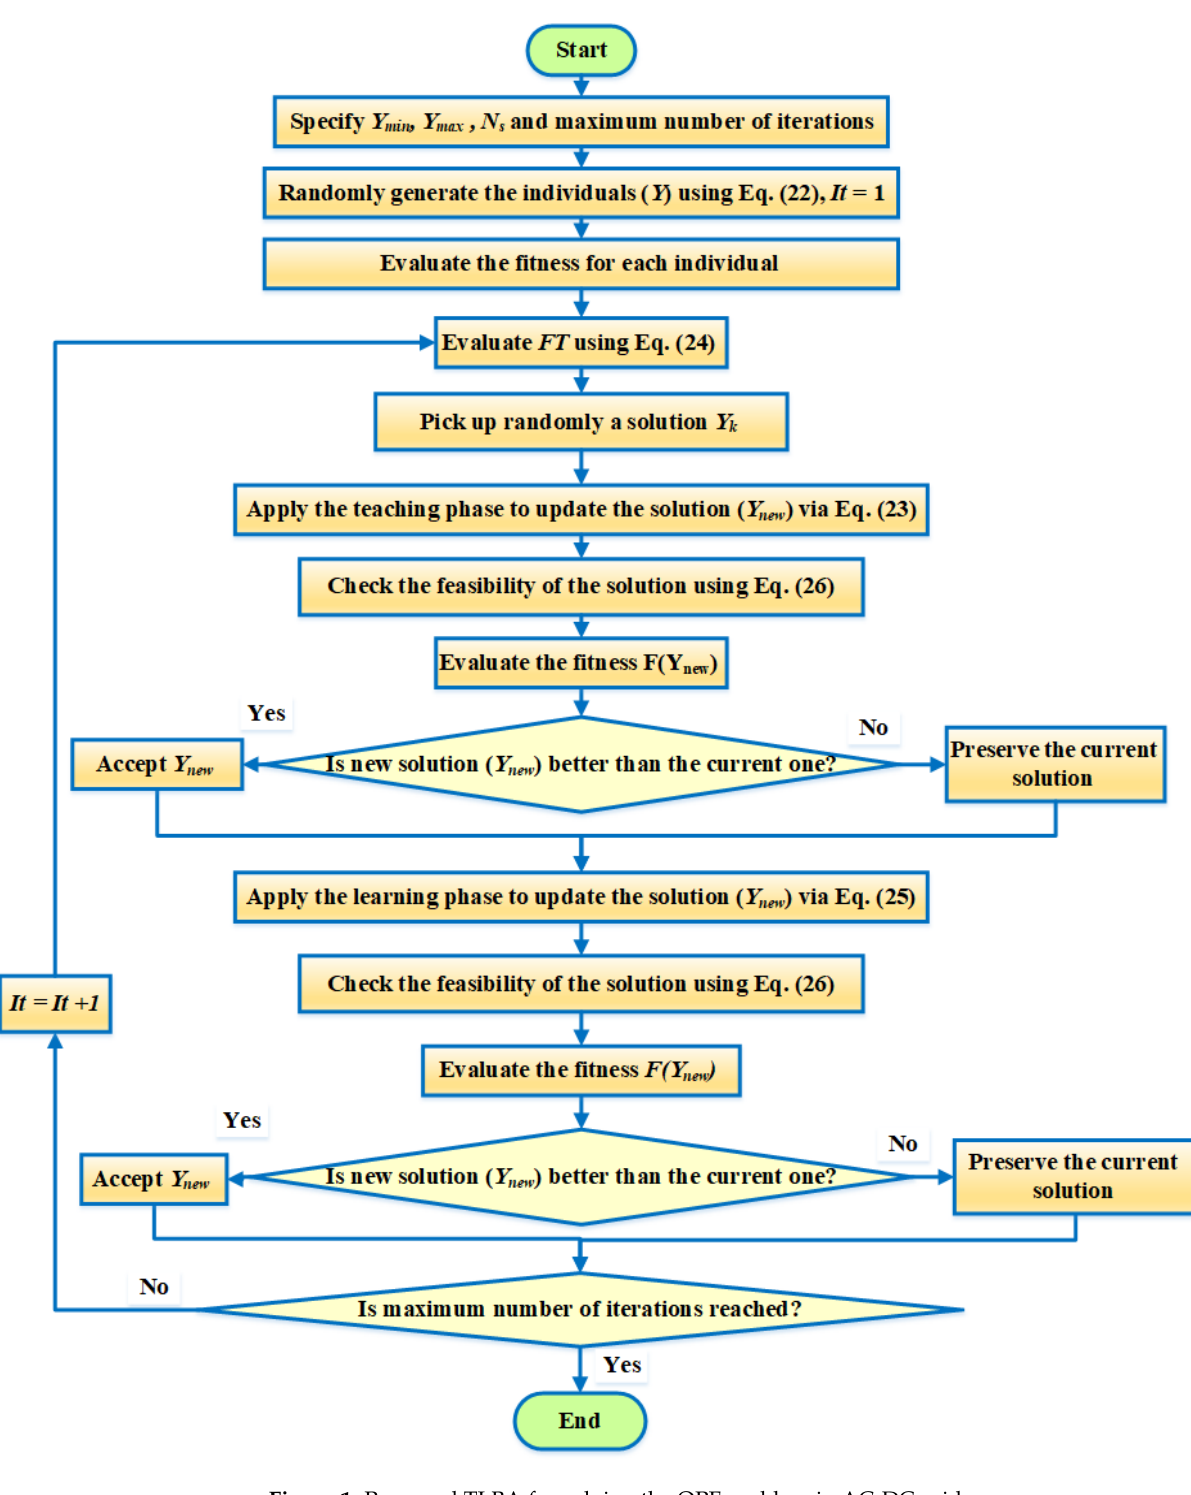
Figure 1. Proposed TLBA for solving the OPF problem in AC-DC grids.